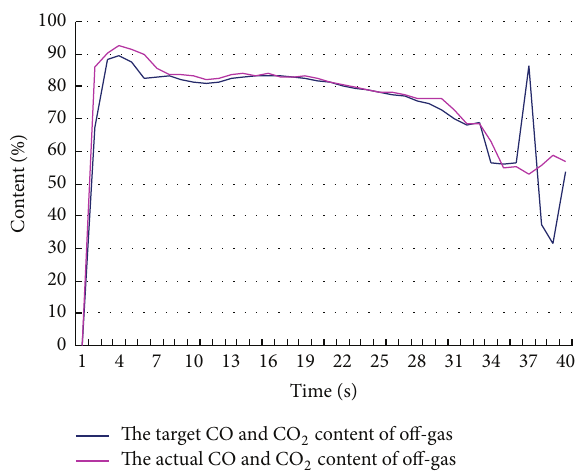
Figure 7: Dynamic curves between the actual flow and the target flow of oxygen.